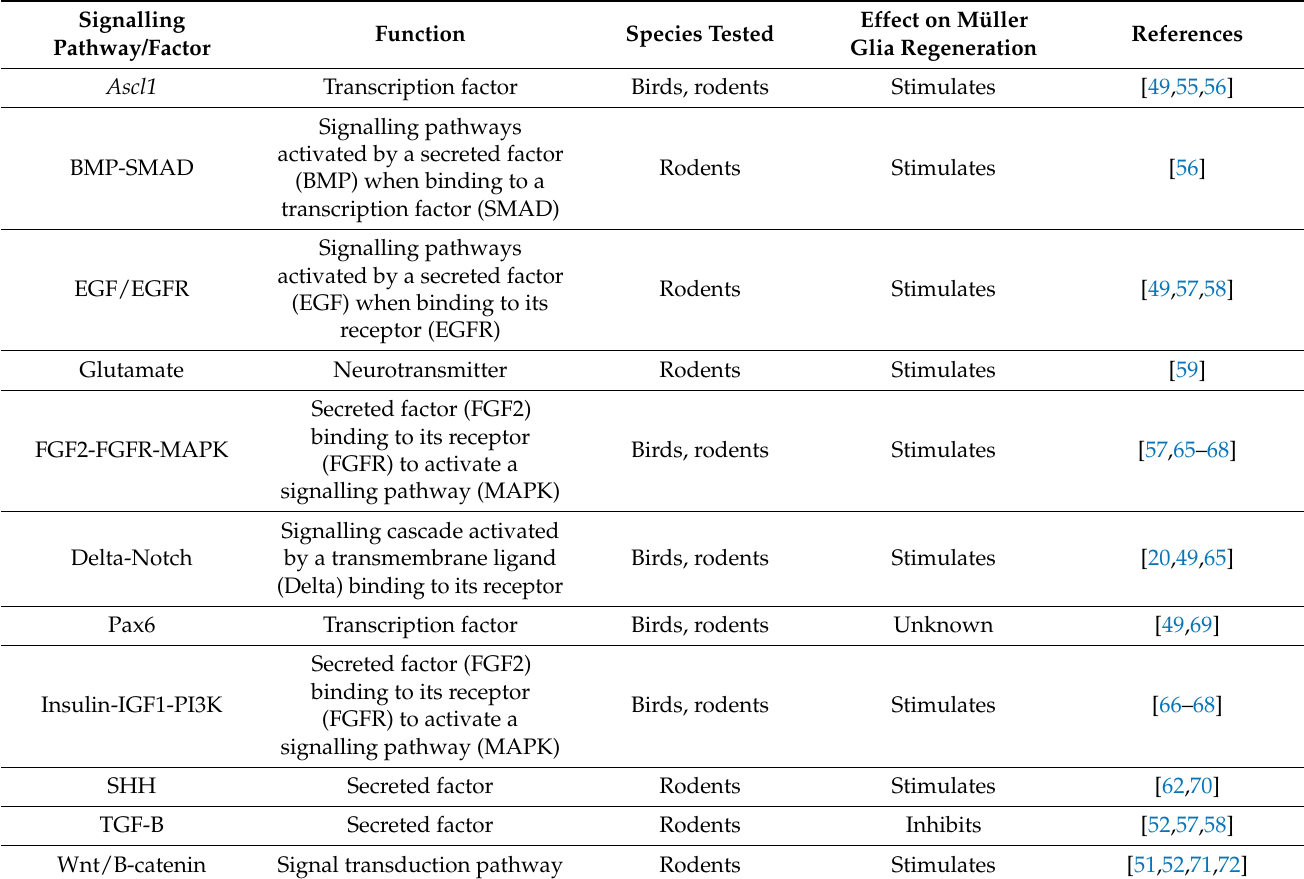
Table 1. Factors affecting Müller glia regeneration in